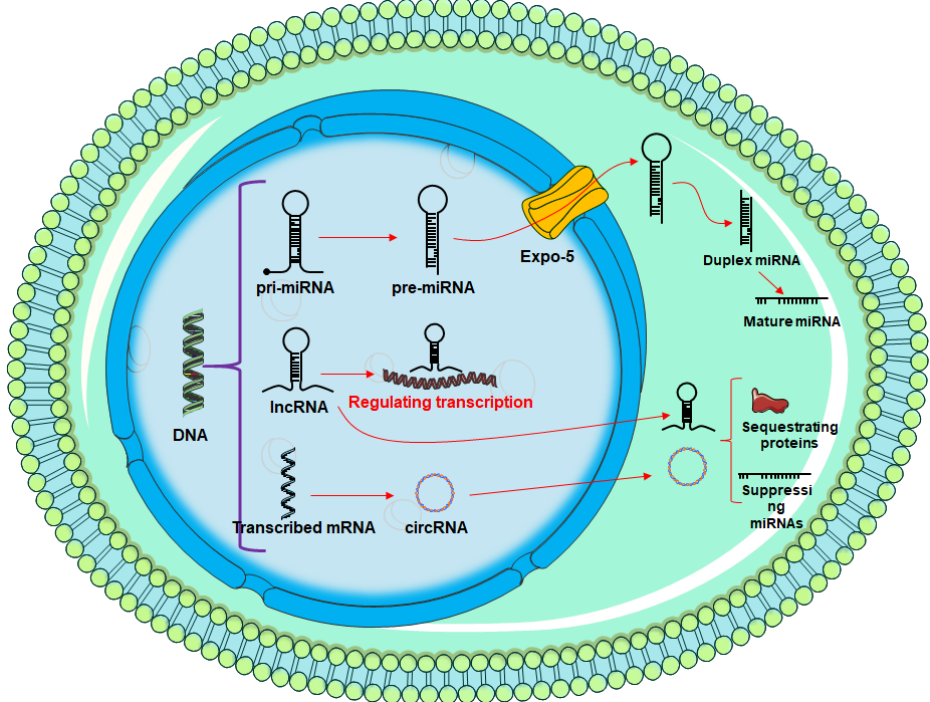
Figure 3. Overview of miRNA and circRNA production. The process is initiated in the nucleus, then exported to the cytoplasm for downstream activities.